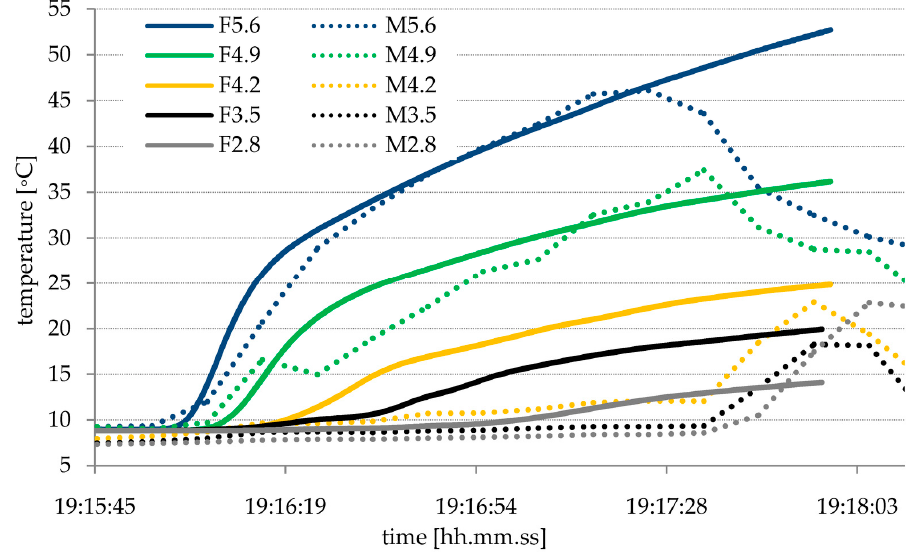
Figure 10. Temperature increase on windward at 5 m from the last tray. Prefix M denotes measurement, prefix F denotes Fluent calculation.